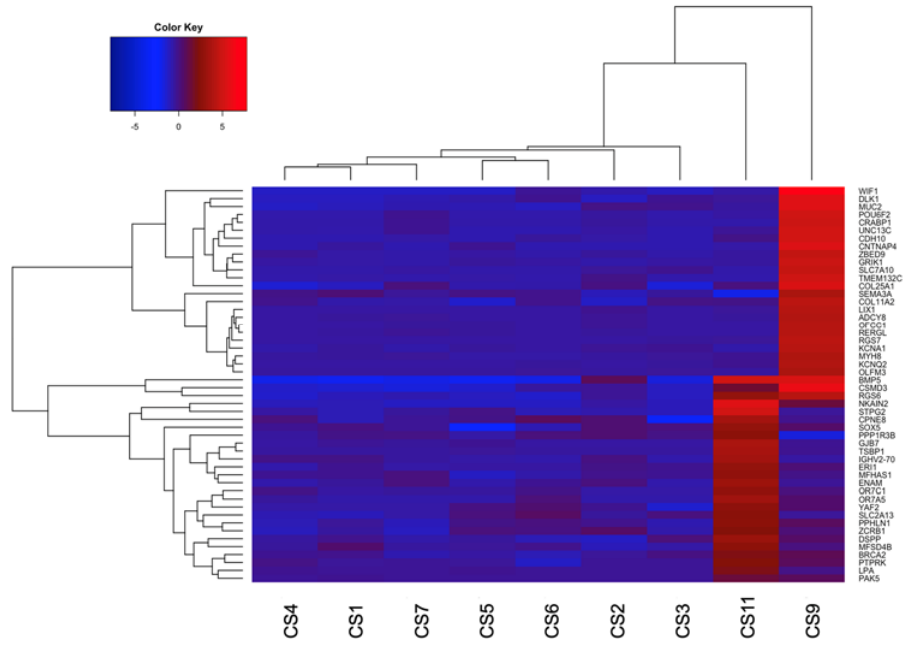
Figure 4. Hierarchical clustering representing the 25 most differentially expressed genes in the leiomyosarcoma sample (CS11) versus the group comprising angiosarcomas (CS6 and CS7) and intimal sarcomas (CS1, CS2, CS3, CS4 and CS5) and the 25 most differentially expressed genes in the osteosarcoma case (CS9) versus the angiosarcoma and the intimal sarcoma samples ( q –value < 0.05).